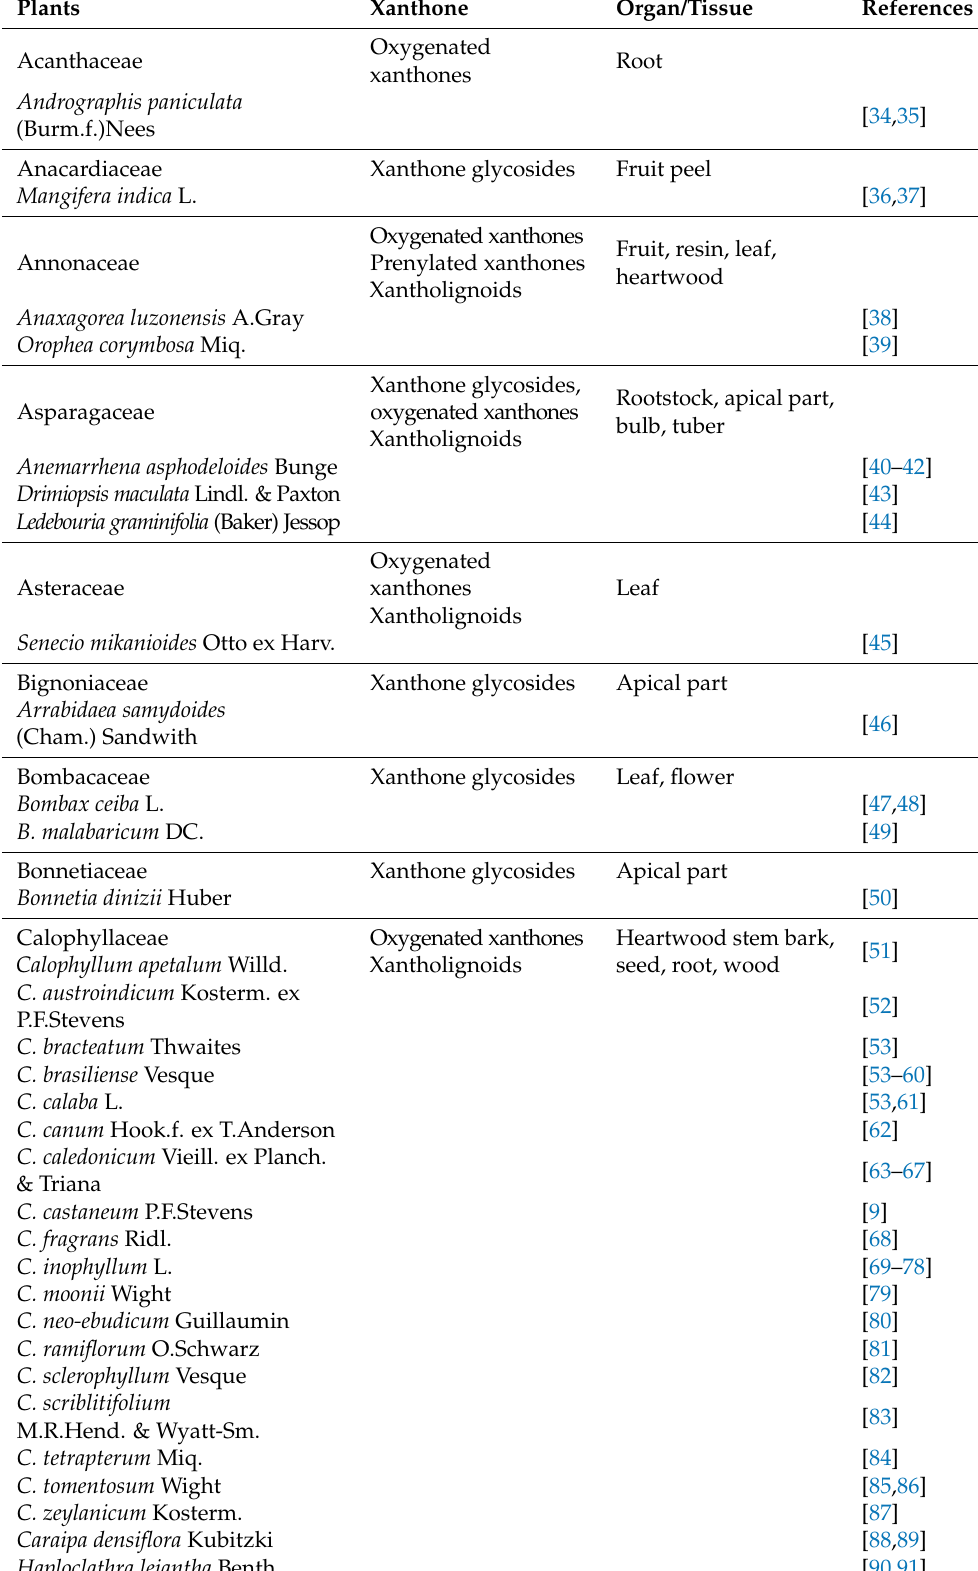
Oxygenated Root xanthones